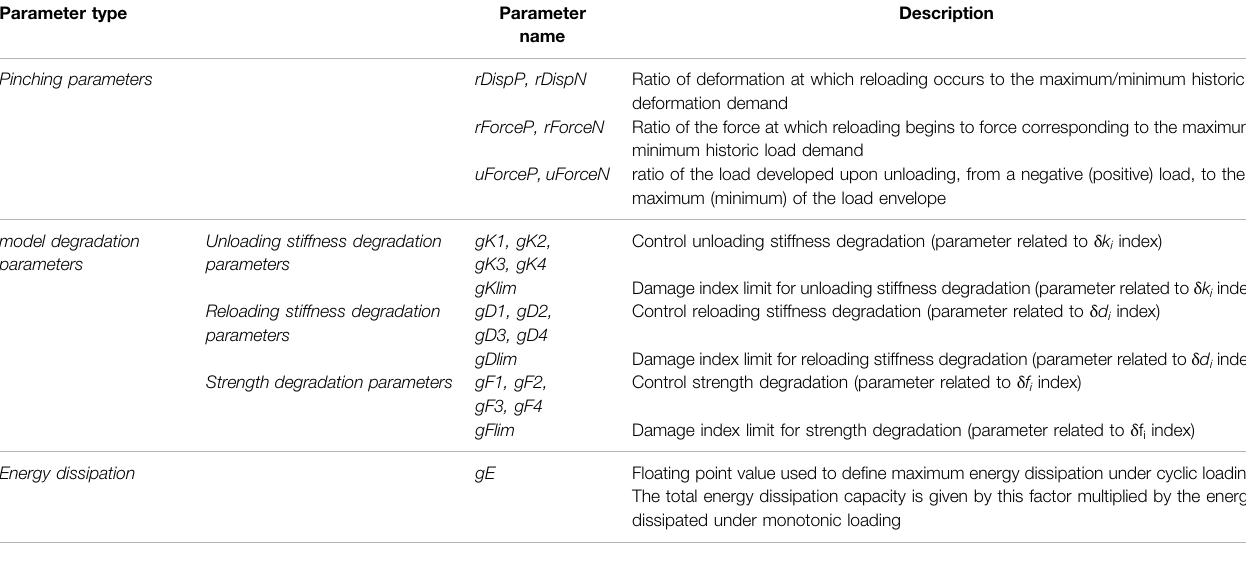
TABLE 9 | Pinching4 ” material model parameters and their